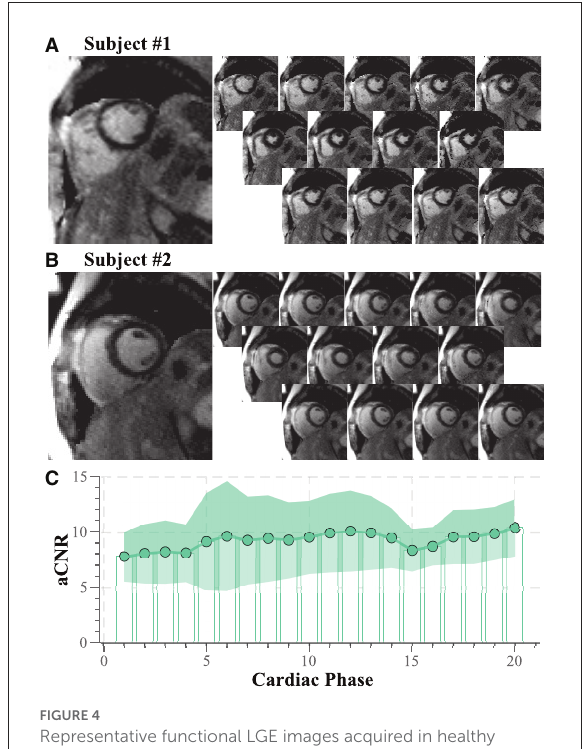
FIGURE4 Representative functional LGE images acquired in healthy volunteers at 3T. (A) Subject #1 with heart rate 57 bpm, number of acquisition phases 13, (B) subject #2 heart rate 57 bpm, number of acquisition phases 13. Thorough suppression of the healthy myocardial tissue with sharp delineation against the blood pools is visible for both subjects. (C) Quantitative analysis of aCNR throughout the cardiac cycle across the six healthy volunteers. Moderate variation of the aCNR is obtained across the cardiac phases.